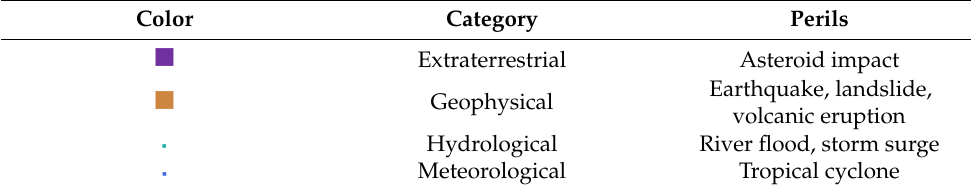
Table A1. Color scheme per peril category.